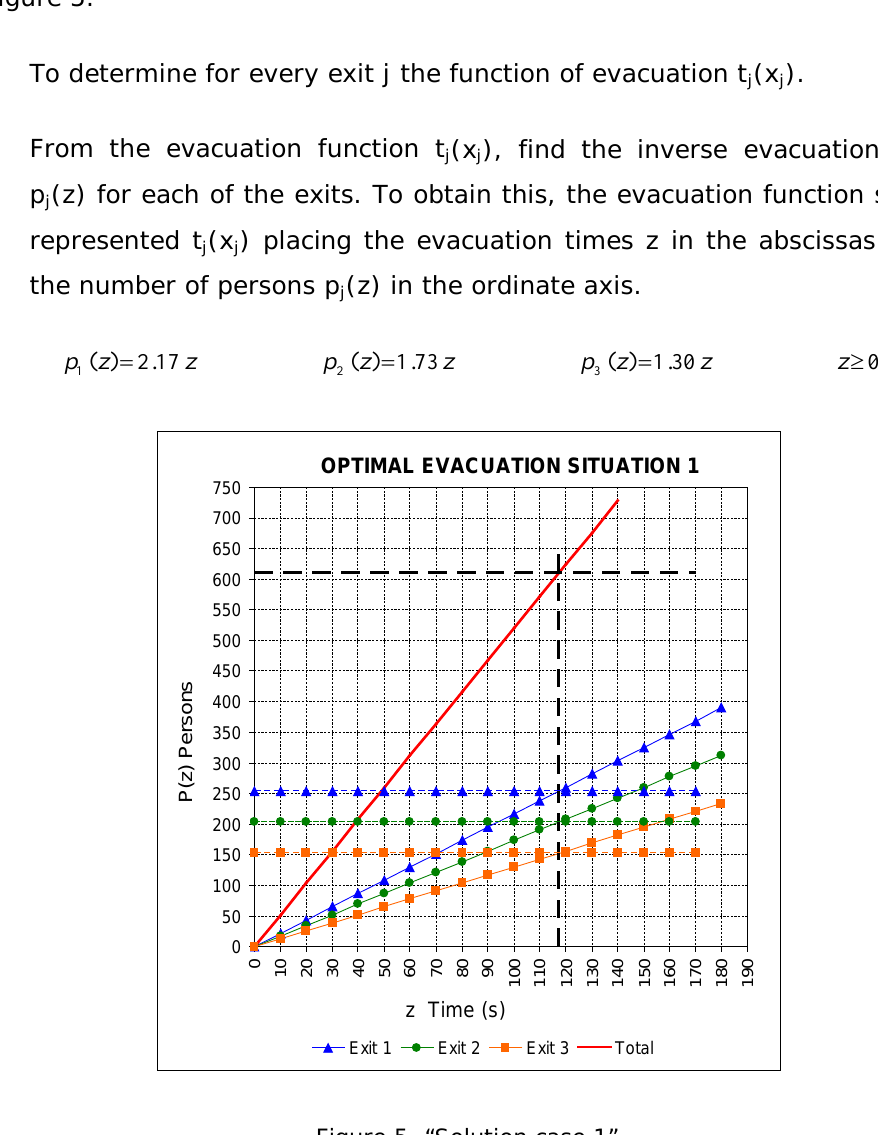
Figure 5. “Solution case